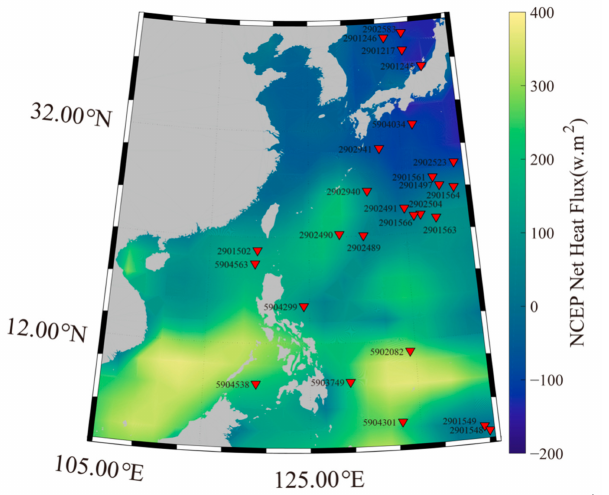
Figure 6. The maps of NCEP total heat flux at 18:00 UTC on 1 July 2015, in which the triangles represent the geographic locations of